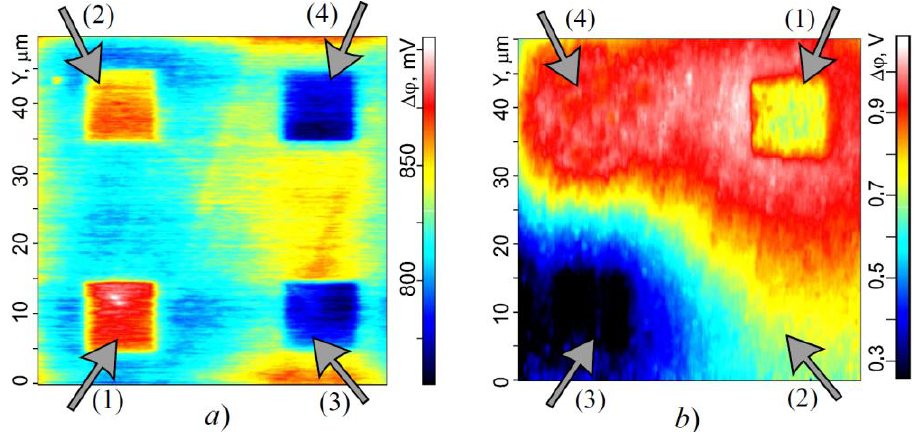
Fig. 4. The AFM electrostatic potential image for the 50×50 um 2 area of semiconductor n- Si{111} — a ) and dielectric SiO 2 — b ) surfaces. The arrows 1 and 2 point at the negative electric charge regions of the local 10×10 um 2 areas, the arrows 3 and 4 point at the ones of positive electric charge. The arrows 1 and 3 correspond to the areas charged through the immediate contact between the probe and the surface. The arrows 2 and 4 correspond to the ones charged through the tunnel-transparent